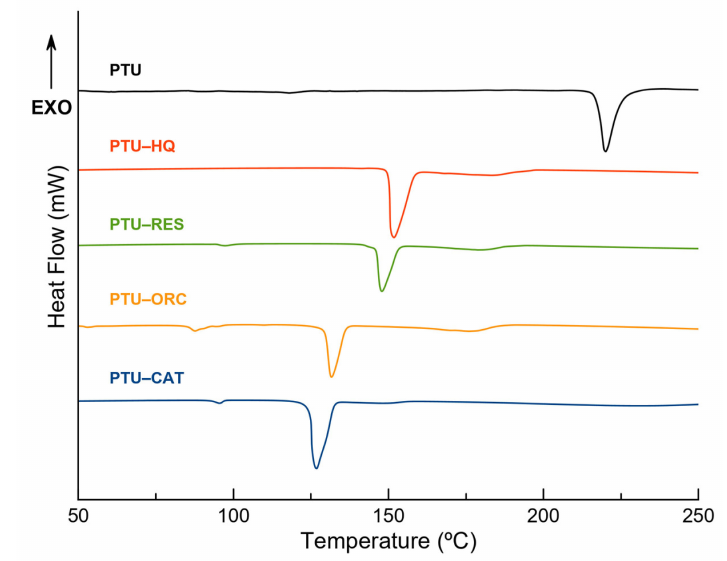
Figure 15. DSC traces of PTU and the new